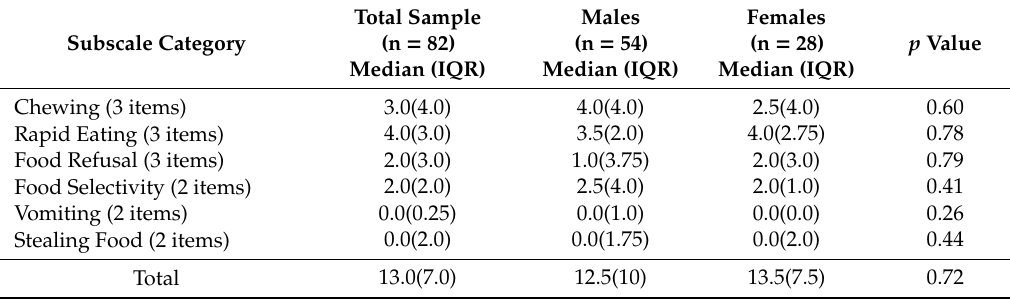
Table 5. Medians and interquartile ranges (IQR) of total STEP-Child and six subscale scores.